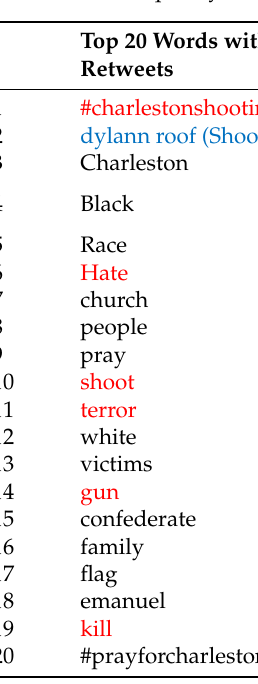
Table 5. Word frequency of the Church massacre.